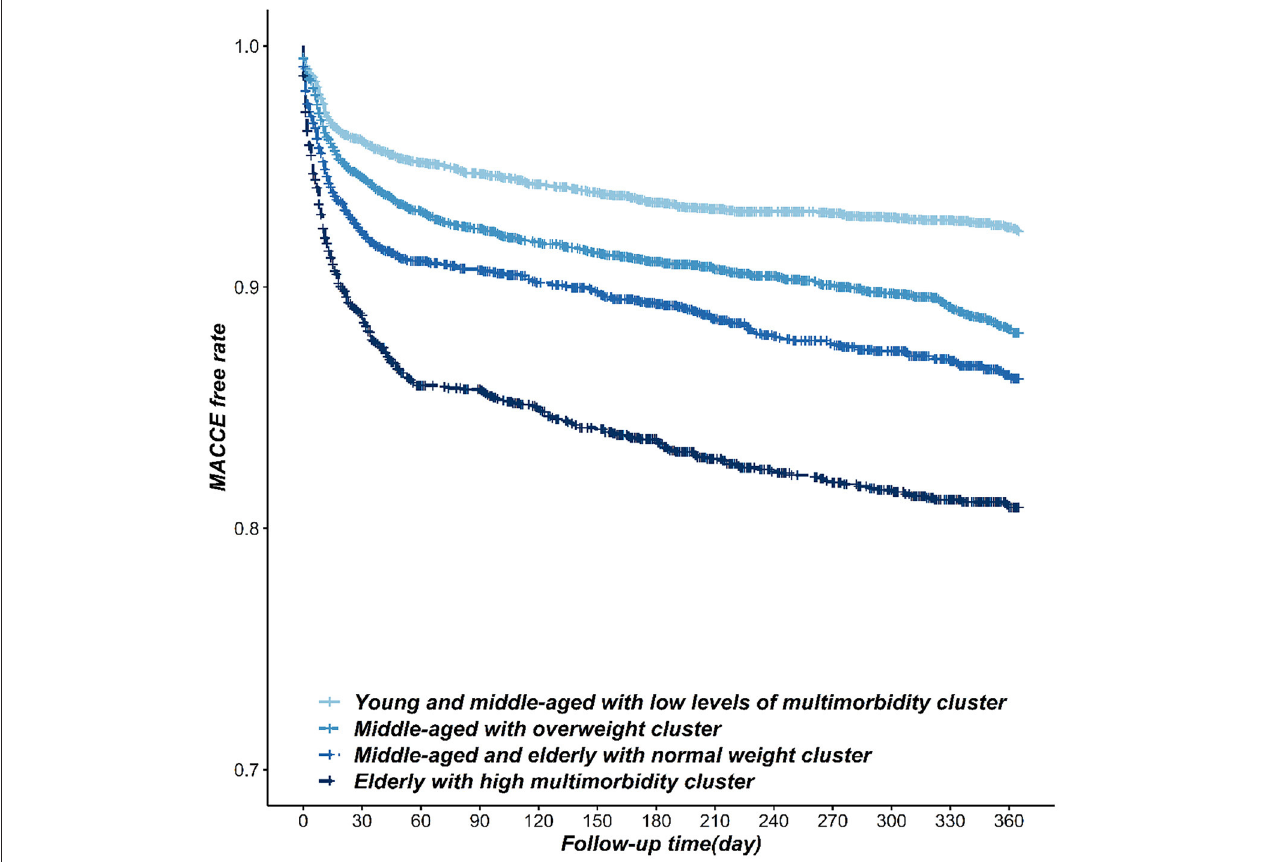
FIGURE 1 | The Kaplan-Meier survival curve of the incidence of MACCE in STEMI patients within different risk factor patterns.